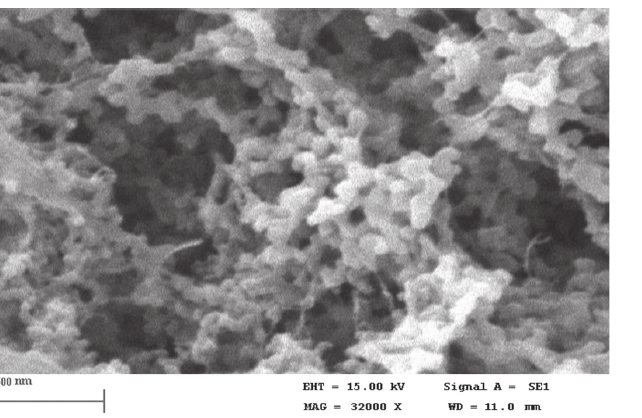
FIGURE 2 - FT‑IR of the prazosin (A), PLGA (B), PEG (C), PEG‑succinic acid (D), PEG‑Praz(E), and PLGA‑PEG‑Praz (F).